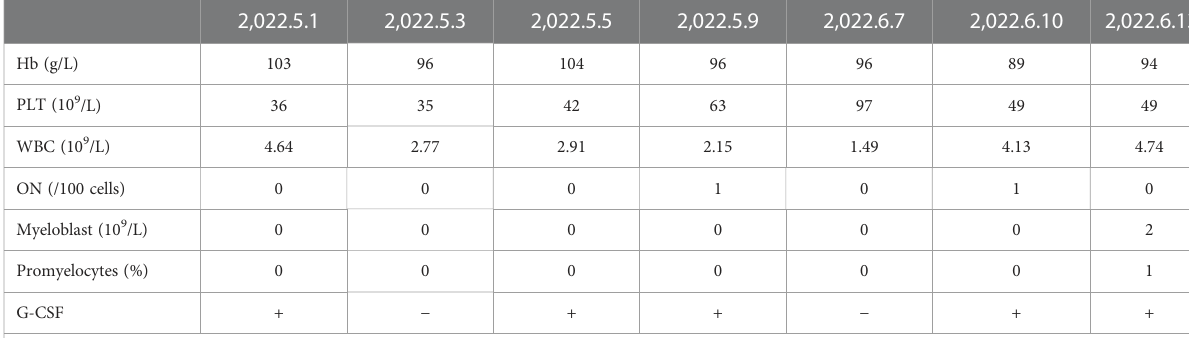
TABLE 2 Peripheral blood tests during usage of G-CSF and